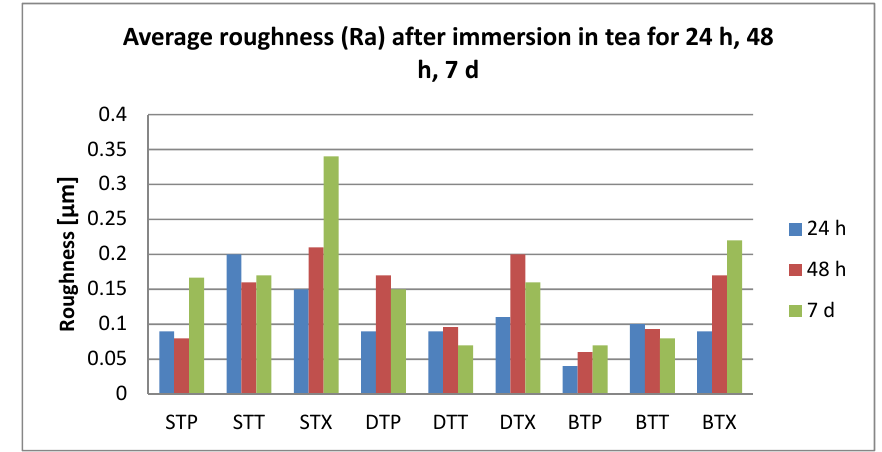
Figure 7. Mean values for average surface roughness (Ra) for the tested samples after immersion in tea.